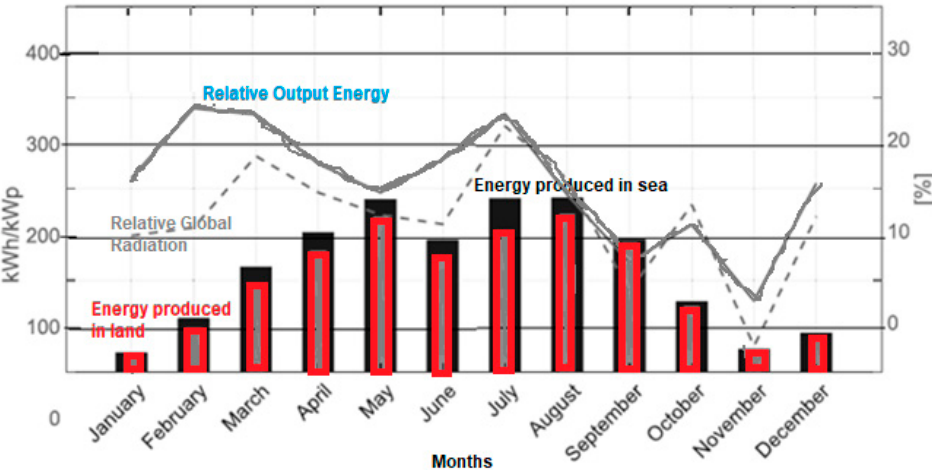
Figure 9. Comparison of the normalized energy yield from FPV and a land system.